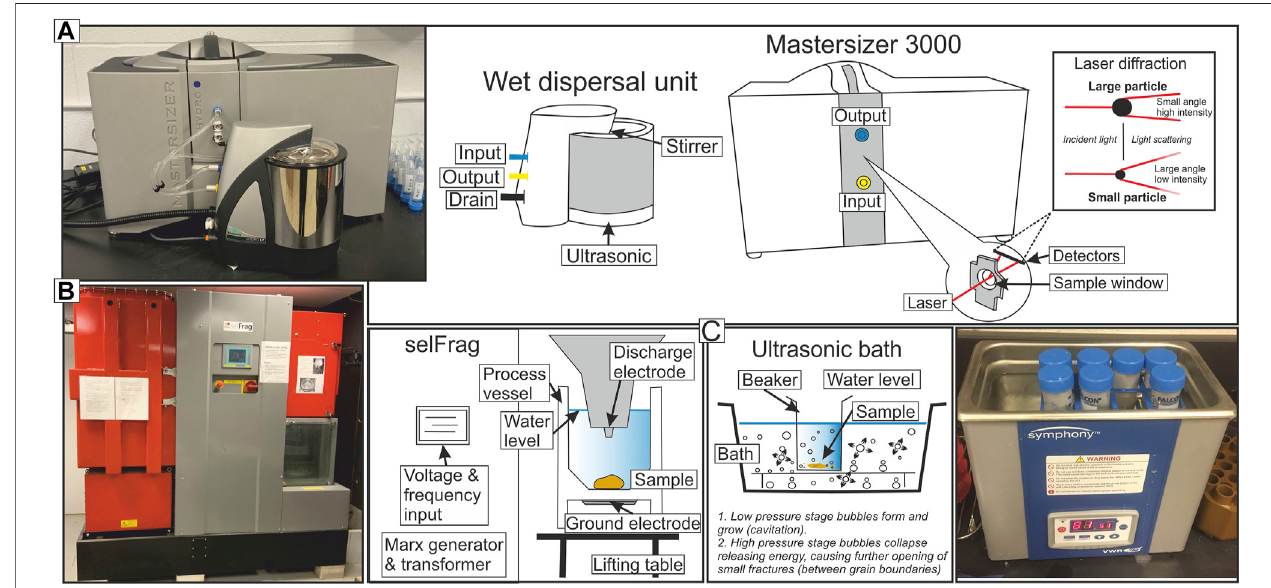
FIGURE 3 | Key equipment used in this study (A) Mastersizer 3000 laser diffraction unit with wet dispersal system. (B) SELFRAG selective fragmentation machine and (C) ultrasonic bath. For use of equipment see methods fl ow chart in Figure 2 .